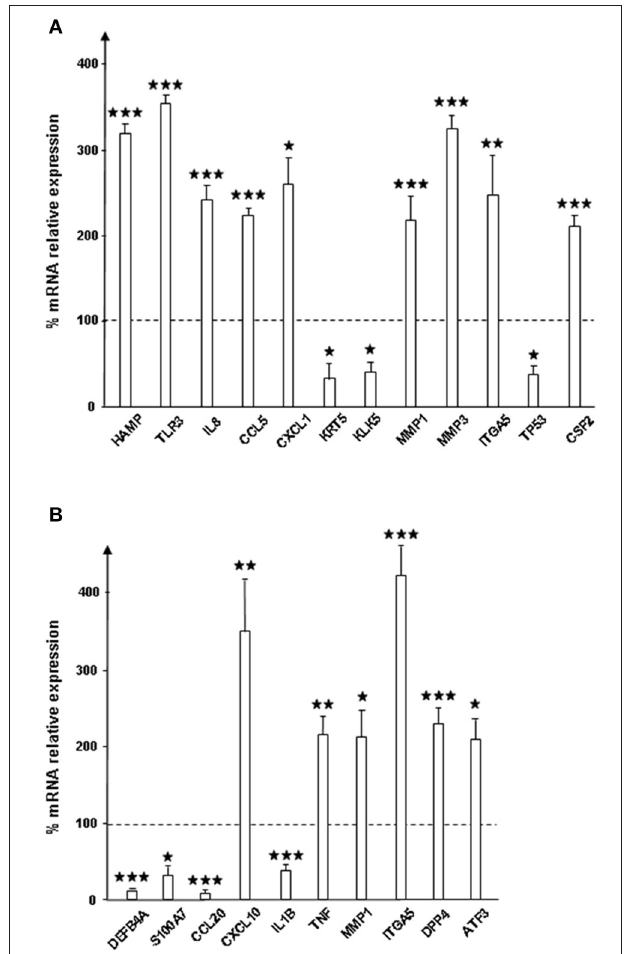
FIGURE 2 | Relative expression of genes encoding for response to infection and inflammation proteins by reconstructed human epidermidis (RHE) exposed to S. aureus MFP03 (A) or S. epidermidis MFP04 (B) pre-treated with Substance P. Results are expressed as percentages to control RHE exposed to bacteria pre-treated with Substance P reverse (dotted line = 100%). Each value represents the mean ± SEM of three independent experiments. Only genes showing significant variation of expression on the 64 ( ⋆ p < 0.05; ⋆⋆ p < 0.01; ⋆⋆⋆ p < 0.001). Names of proteins are given in Table 1